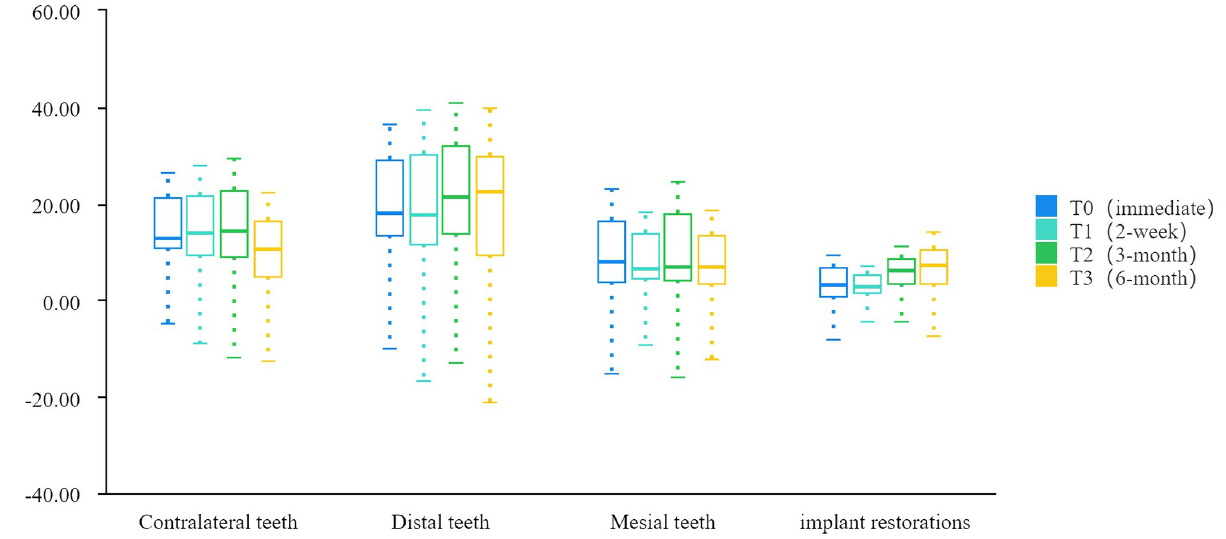
Fig 7. Comparison of the bite force distributed on implant restorations and teeth at different